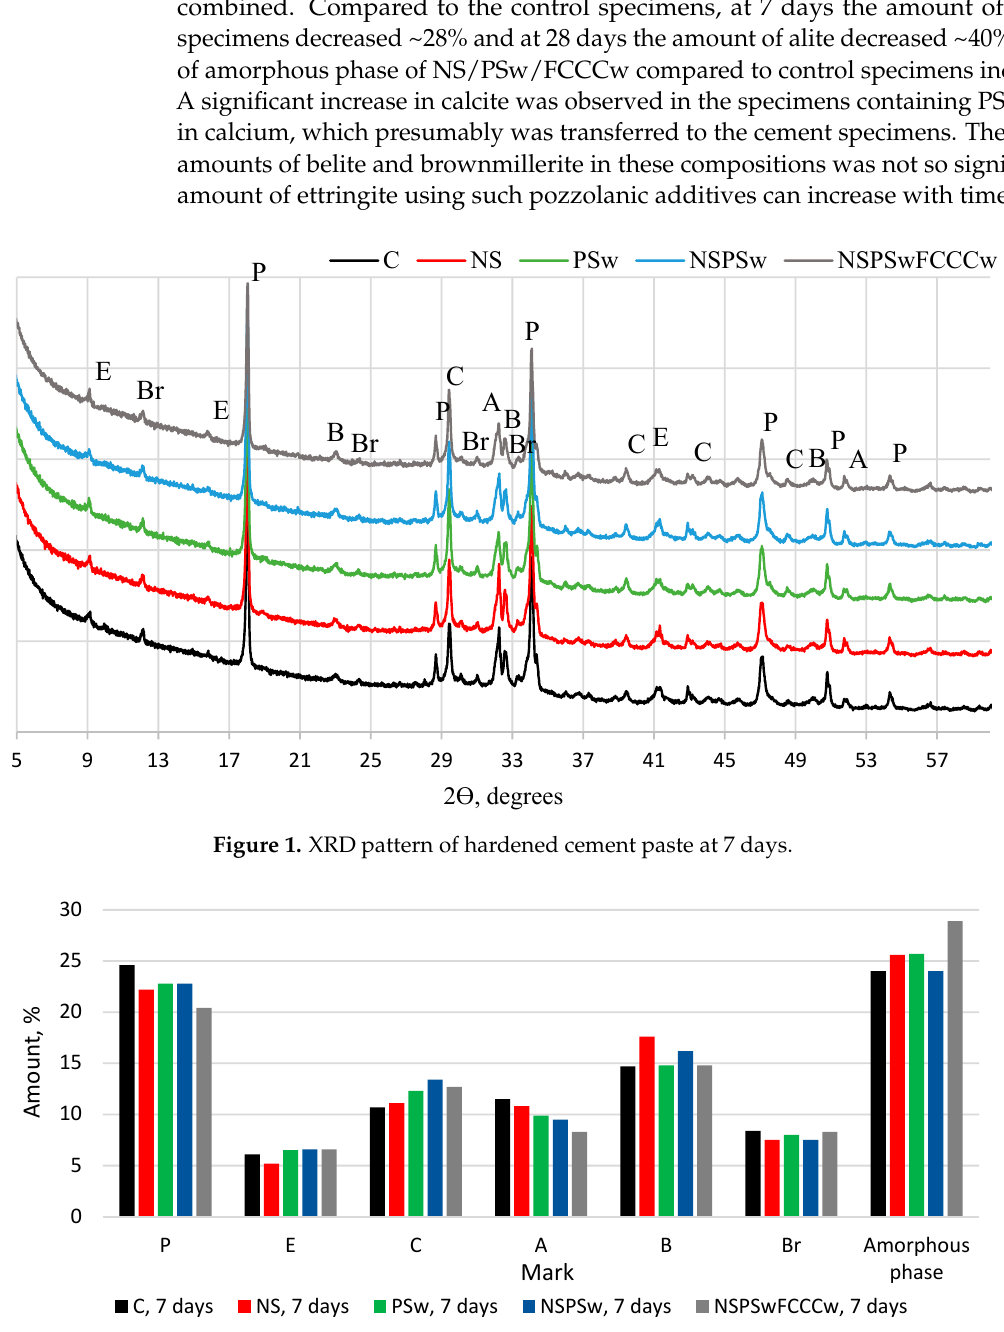
Figure 3. XRD pattern of hardened cement paste at 28 days. Figure 4. The comparison of the amount of minerals and amorphous phase at 28 days.